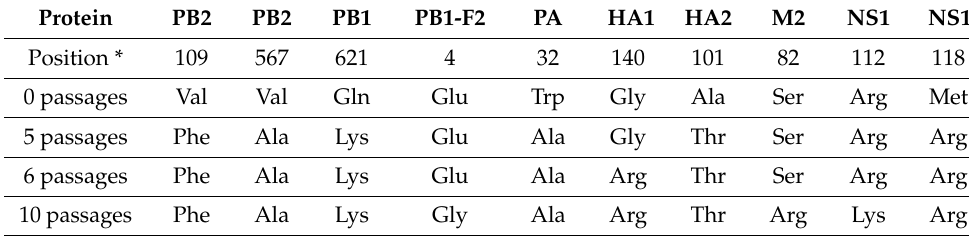
Table 1. Mutations emerging during serial passages of the R0p through chicken